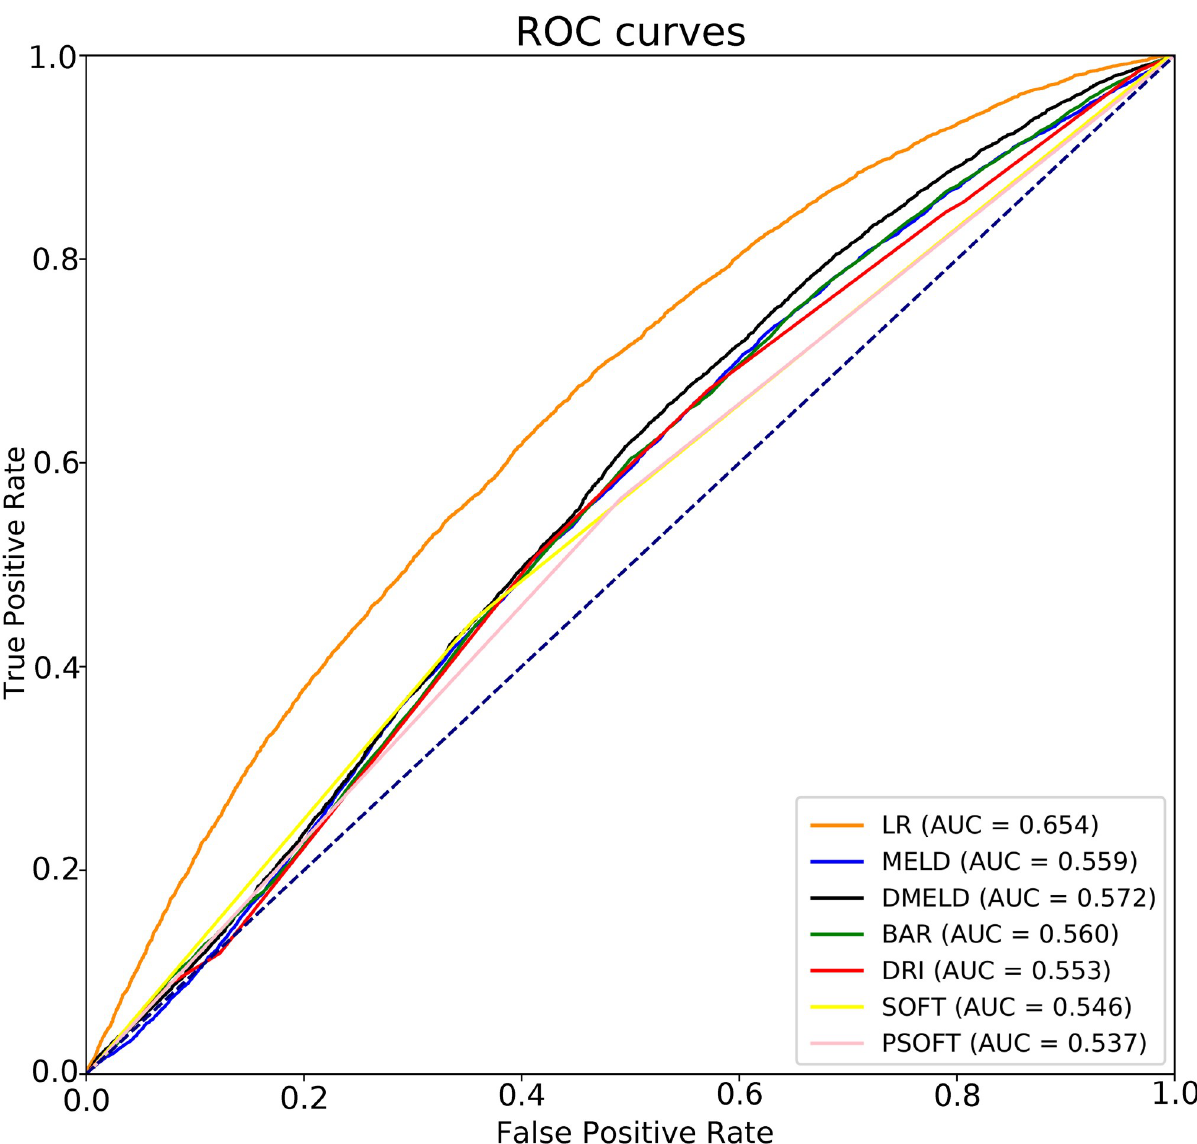
Fig 3. Comparisons of ROC curves for LR vs MELD, D-MELD, BAR, DRI, SOFT and P-SOFT scores on the 5-years-end-point dataset.